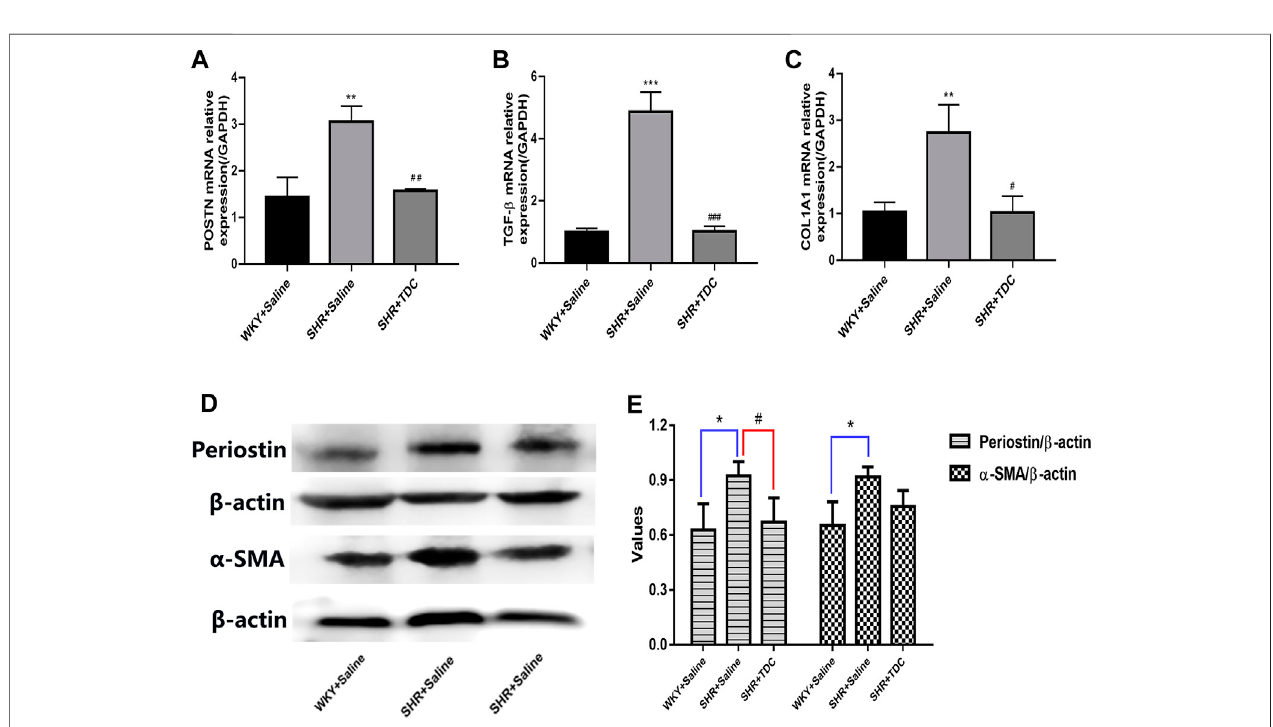
FIGURE 6 | Effect of TDC on periostin and TGF- β -mediated fi brosis pathways (A – C) mRNA expressions of periostin (A) , TGF- β (B) and COL1A1 (C) were determined with real-time qPCR and data were normalized to that of GAPDH (D – E) protein expression of periostin and α -SMA were assessed by Western blot (D) Representative images and (E) Bar graph quanti fi cation of the WB data. Data are expressed as mean ± SD, n (cid:2) 3. * p < 0.05 ** p < 0.01, *** p < 0.001 vs. WKY rats; # p < 0.05, ## p < 0.01, ### p < 0.001 vs. SHR.